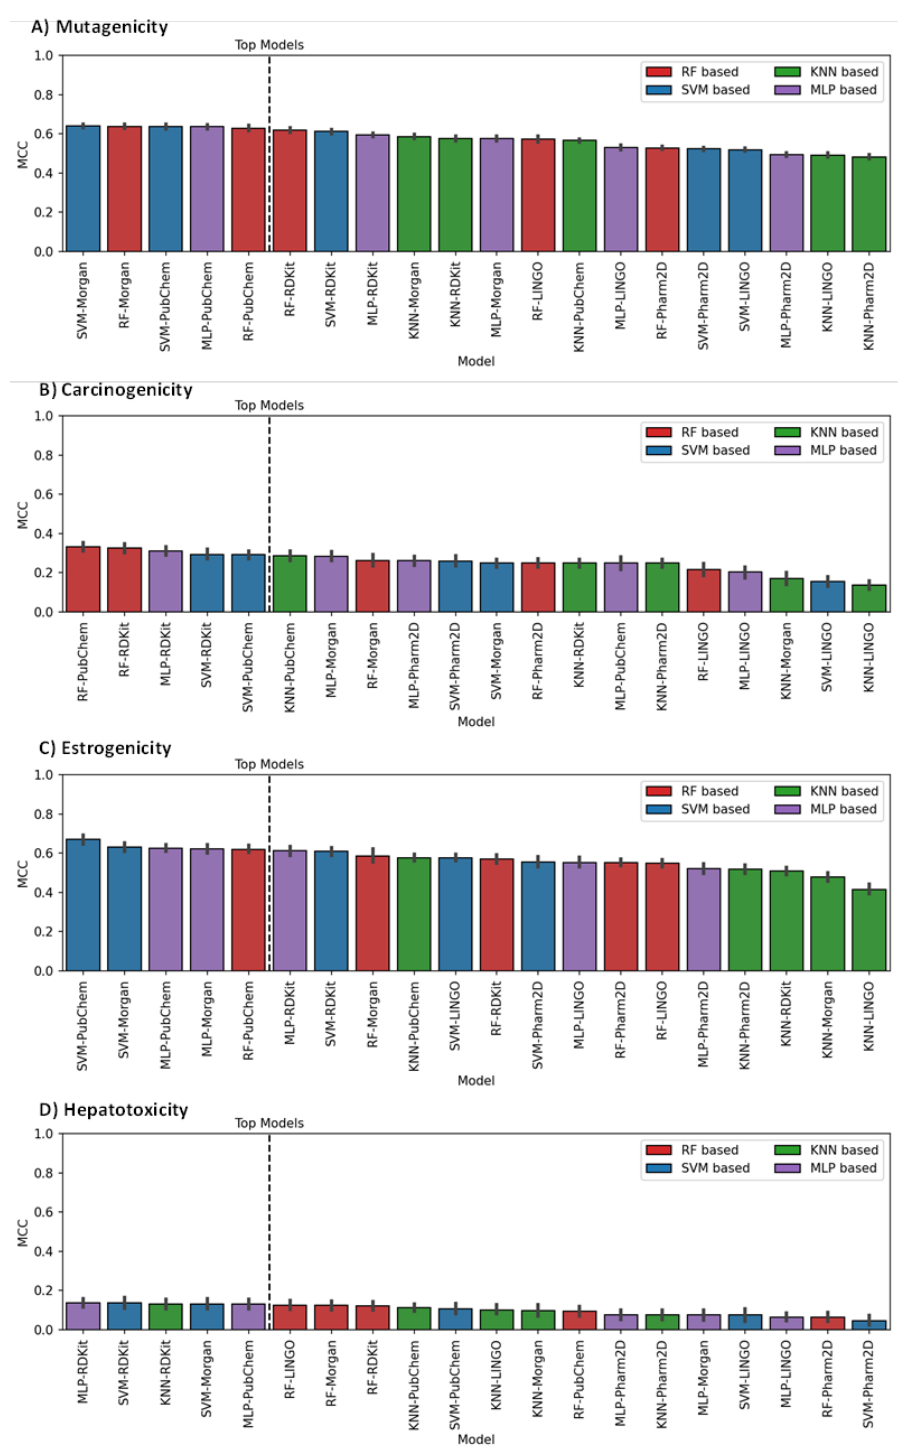
Figure 1. Evaluation results, expressed in terms of MCC, obtained for all different models developed for the ( A ) mutagenicity, ( B ) carcinogenicity, ( C ) estrogenicity and ( D ) hepatotoxicity endpoints. The 5 top-scored models for each endpoint are separated from the others by a black dashed line.